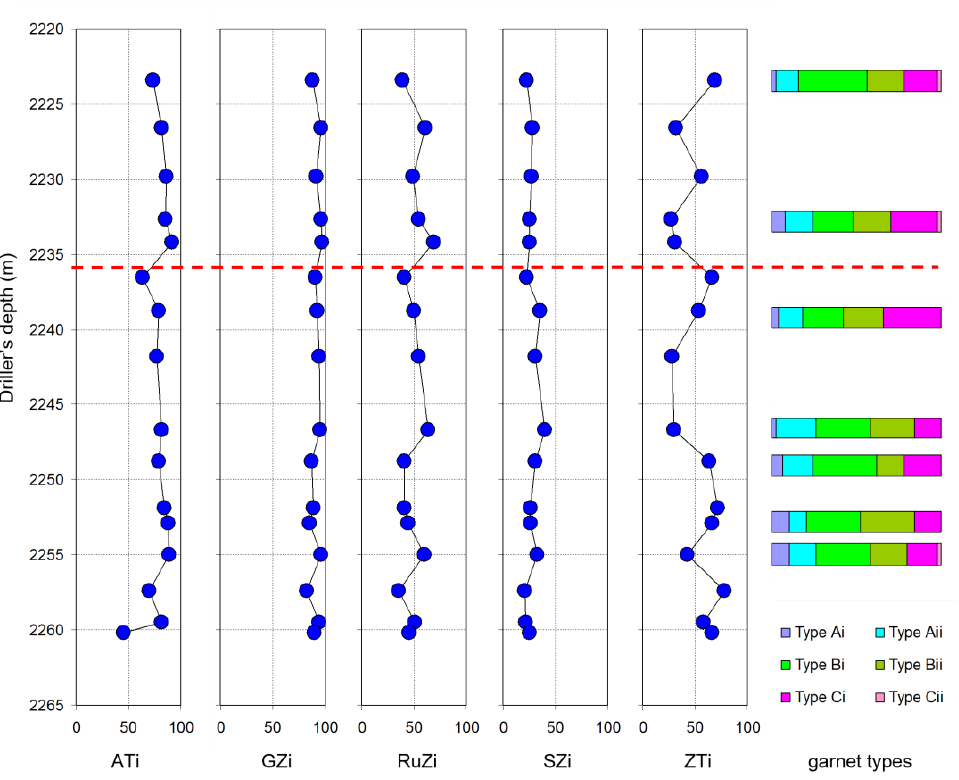
Figure 13. Stratigraphic variations in heavy mineral indices and garnet assemblage compositions in the cored Hermod S2 Mbr in Caterpillar discovery well 24/9-10S. The red dashed line marks the boundary between the upper stratified section and the lower debrite-rich interval. See Figure 6 for the definition of garnet types Ai, Aii, Bi, Bii, Ci and Cii.